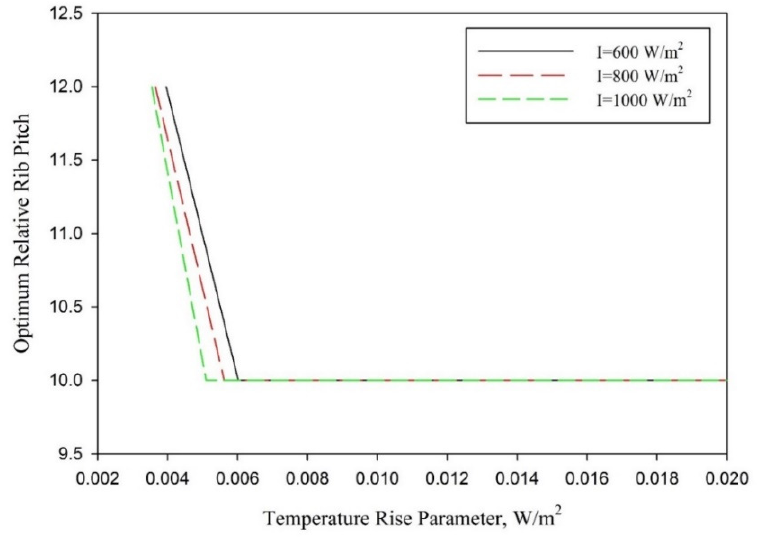
Figure 13. Optimum value of relative rib pitch.